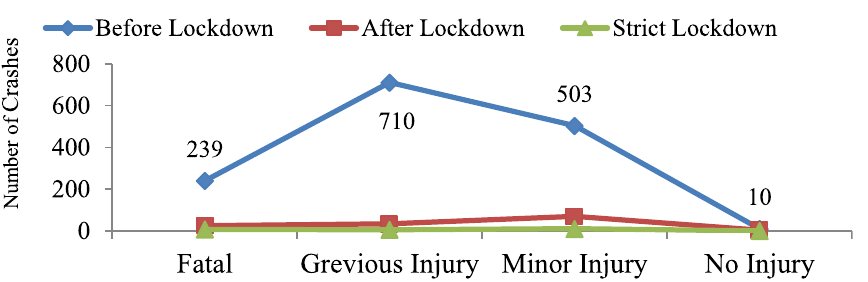
Fig. 3 Analysis of crash data by classification of crash